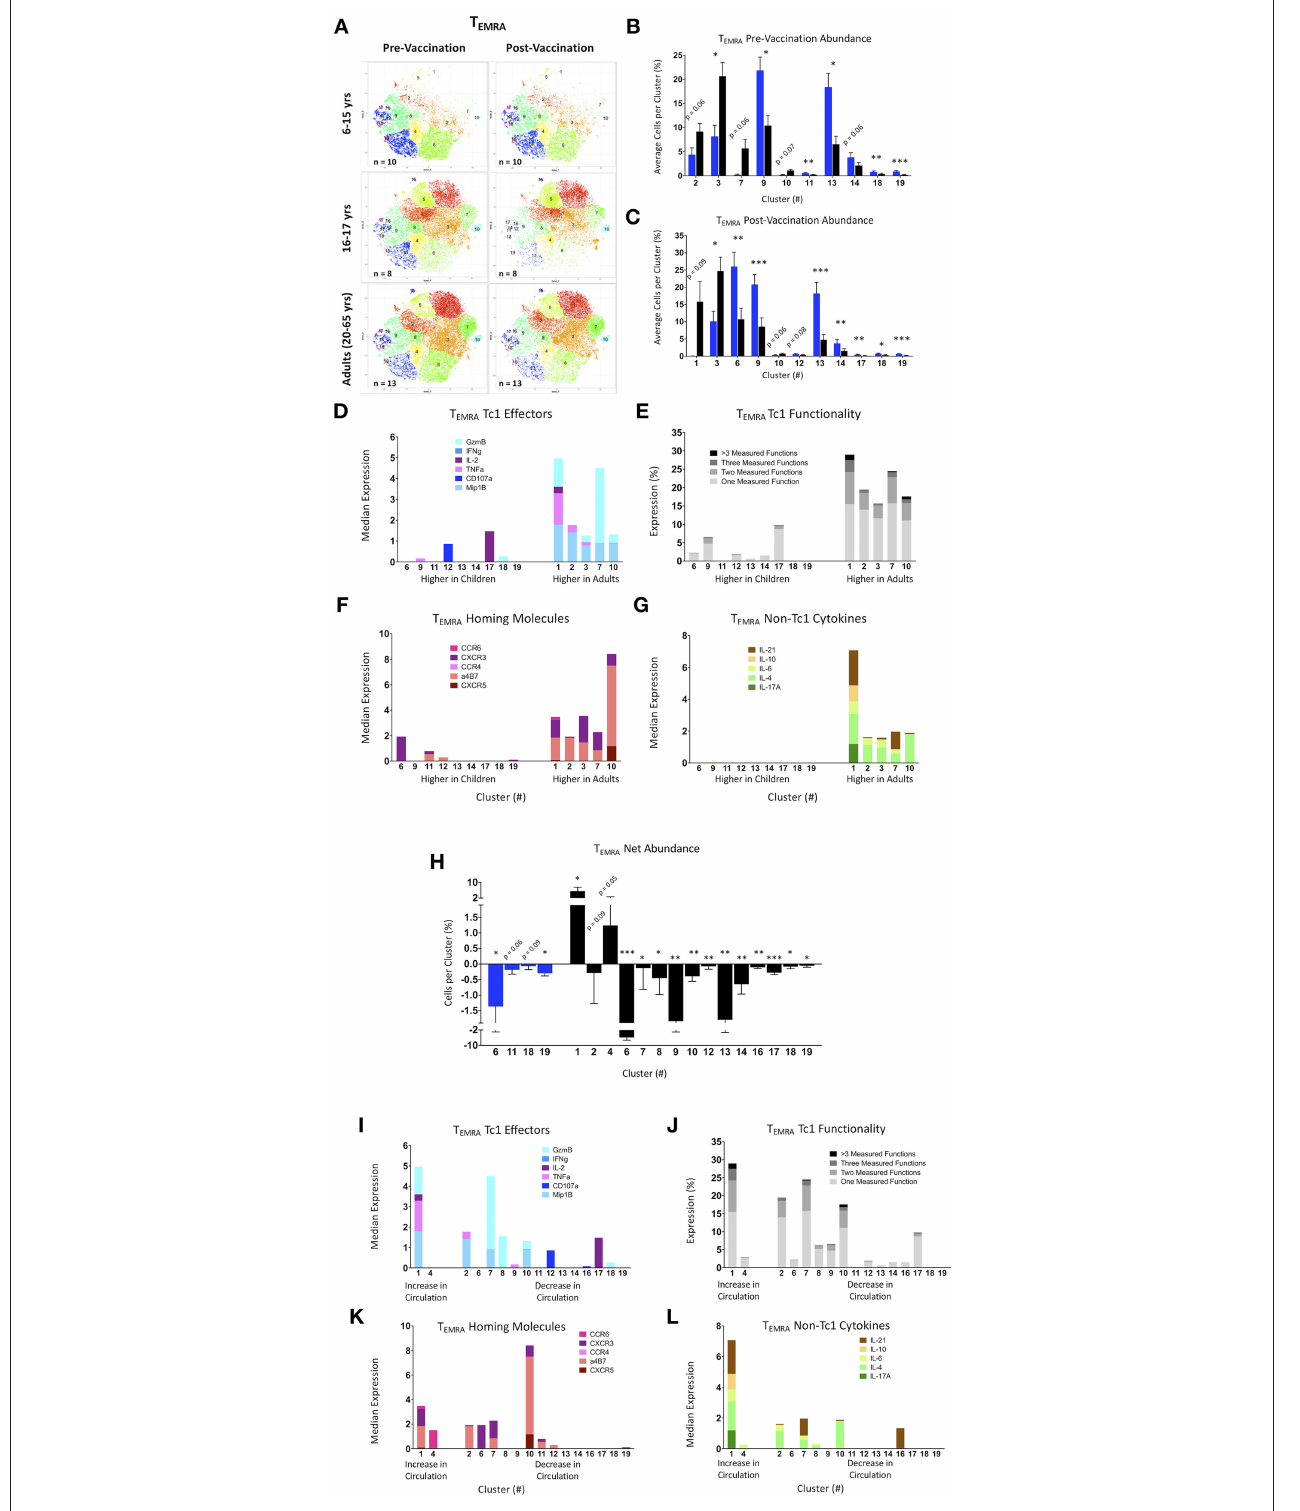
FIGURE 6 | tSNE analysis of activated CD8 + T effector memory RA (T EMRA ) populations. (A) tSNE maps of pre- and post-Ty21a vaccinated 6–15 year old, 16–17 year old, and adult participants. (B,C) Significantly different clusters between age groups (6–15 year old and 16 years and over) represented by bar graphs identifying the average percent of cells per volunteer per cluster in pre-Ty21a (B) and post-Ty21a (C) immunization timepoints. (D–G) Functions of significantly different tSNE clusters from (B,C) , divided into: (D) median expression of Tel effector functions MIP1 β , CD107a, TNF α , IL-2, IFN γ , and Granzyme B (GzmB), (E)